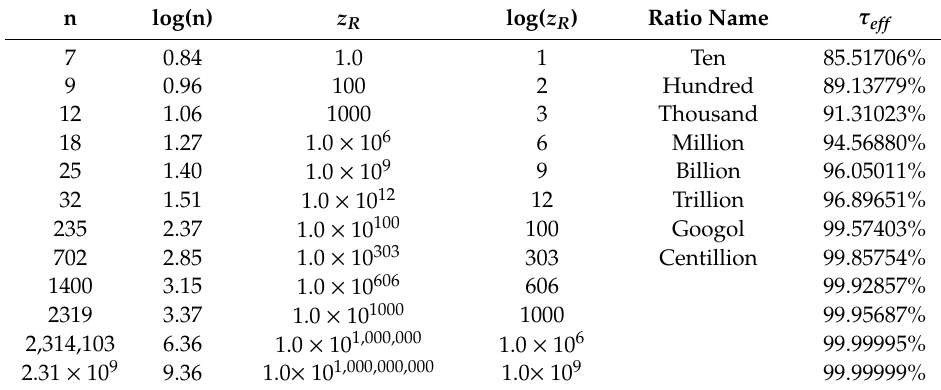
Table 2. Extrapolated